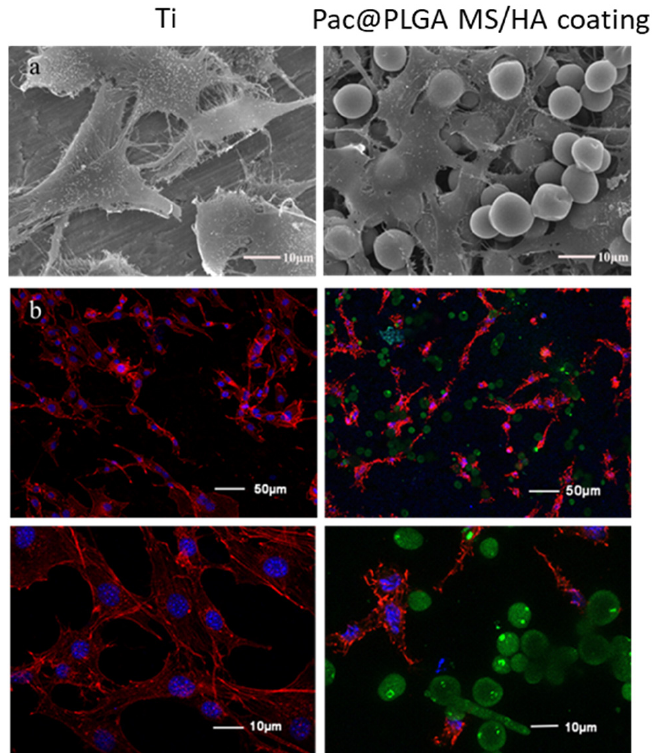
Figure 3. The adhesion of MC3T3-E1 cells cultured on Ti and Pac@MS/HA coating of Ti for 6 h was observed through SEM and CLSM. ( a ) SEM images of MC3T3-E1 cells on Ti and Pac@PLGA MS/HA coated Ti surface. ( b ) Confocal images of MC3T3-E1 cells on Ti and Pac@PLGA MS/HA coated Ti surface. The blue fluorescence is from DAPI in the nucleus; the red fluorescence is from phalloidin in the cell membrane; and the green fluorescence is from Pac@PLGA microspheres.